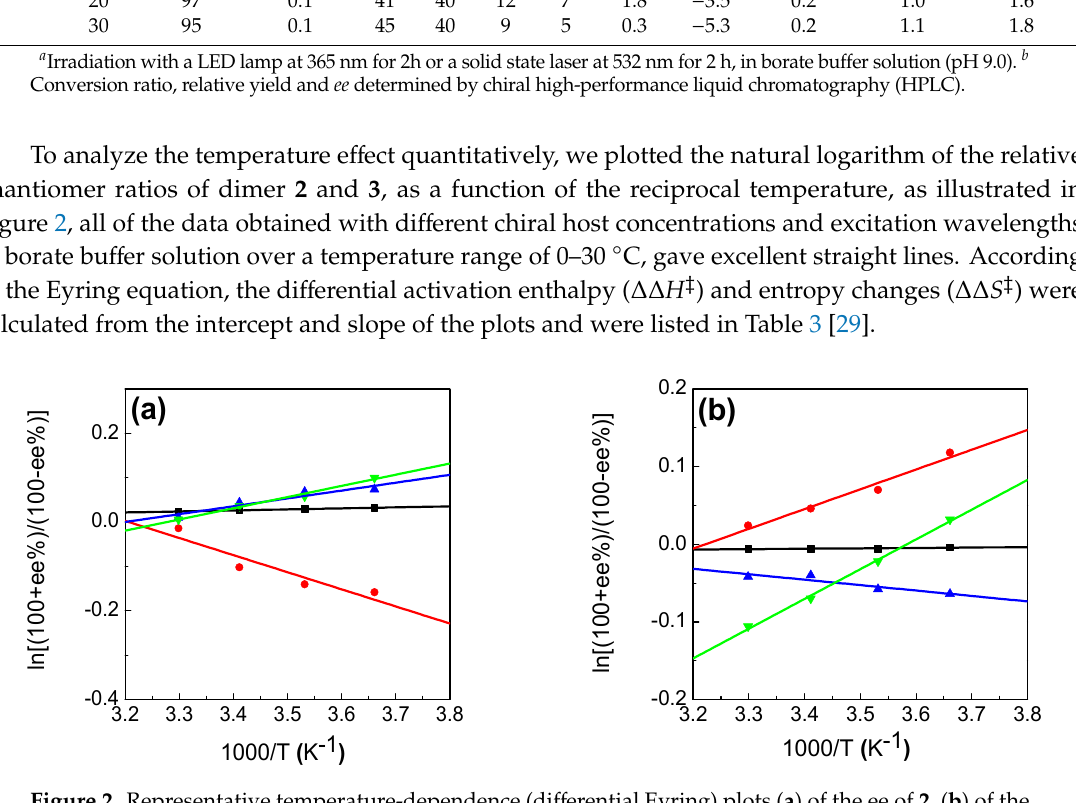
Figure 2. Representative temperature-dependence (differential Eyring) plots ( a ) of the ee of 2 , ( b ) of the ee of 3 obtained in the photoreaction of AC irradiated with 365 nm LED and 0.01 mM Pt-2 ( ■ ) or 0.1 mM Pt-2 ( ● ), with 532 nm laser and 0.01 mM Pt-2 ( ▲ ) or 0.1 mM Pt-2 ( ▼ ) in 25 mM borate buffer solution. Table 3. Di ff erential activation parameters determined from the temperature dependence of the ee of cyclodimers 2 and 3 in the photocyclodimerization of AC catalyzed by Pt-2. [Sen.] /